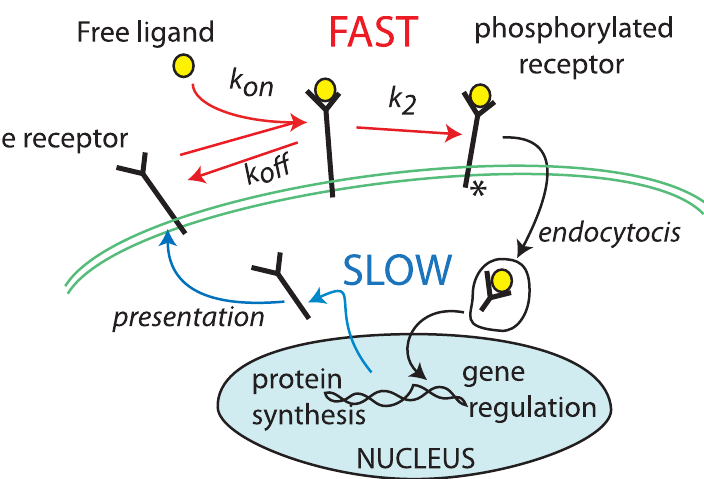
Fig 2. Ligand-receptor dynamics forms a basis for our model. FGF or Wnt receptors are synthesized, presented on the cell surface, and, after bindingto ligand, phosphorylated and internalizedby endocytosis. Here we assume that ligand-receptor bindingis rapid on the timescale of such receptor dynamics, so that we can approximate the bound receptor level by Eq